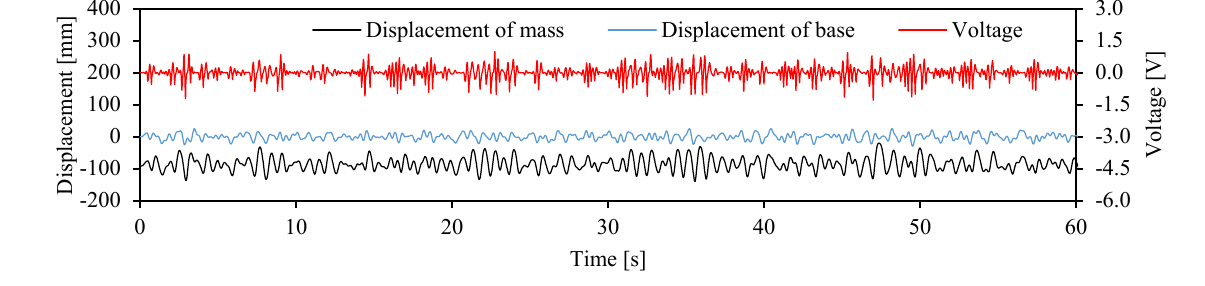
Figure 22. Results based on co-excitation of random and 2.2 Hz periodic signals. The effects of periodic signal frequencies on the vibration displacement and vibration power generated are summarized in Figures 23 and 24, respectively. Based on Figure 23, the vibration displacement of the support point did not change substantially as the exci- tation frequency increased, but the vibration displacement of the mass block amplified